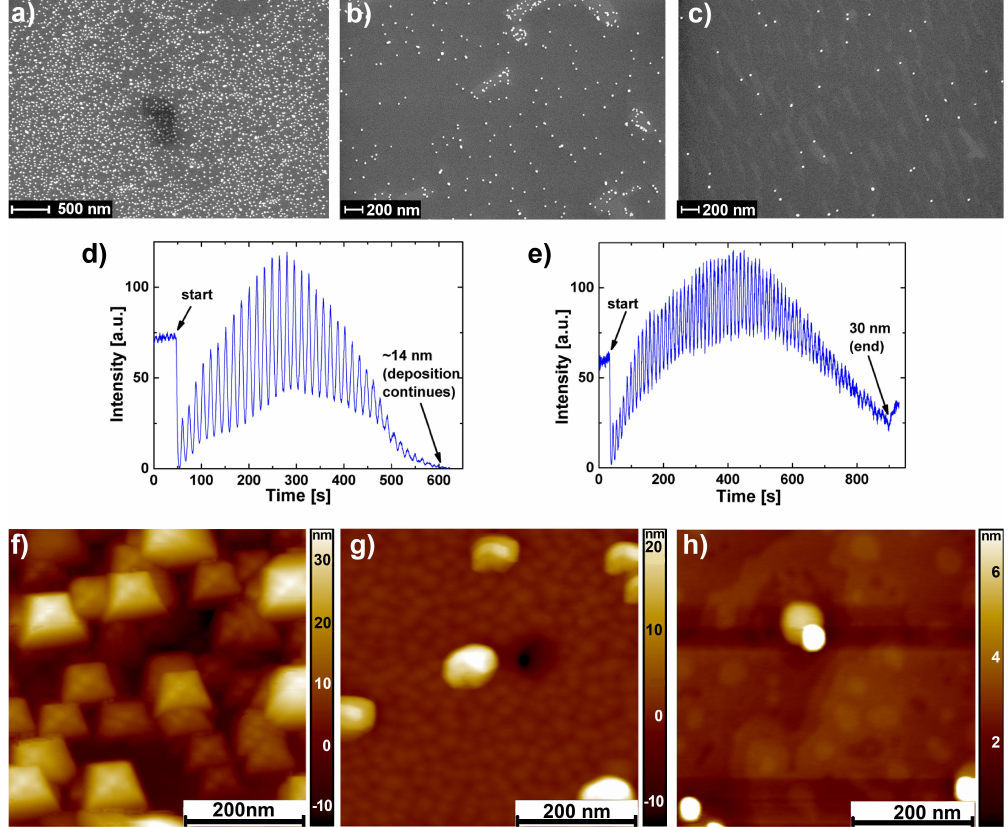
Figure 1. Growth of 30-nm stoichiometric SrTiO 3 on Nb:STO substrates covered with various densities of AuNPs. ( a – c ) SEM images of the Nb:STO substrates with decreasing density from high (a) to low (c). ( d ) Evolution of the reflection high energy electron diffraction (RHEED) specular spot intensity for medium AuNP density. ( e ) Evolution of the RHEED specular spot intensity for low AuNP density. ( f – h ) Corresponding topography images of the resulting 30-nm stoichiometric SrTiO 3 thin films with decreasing AuNP density from high (f) to low